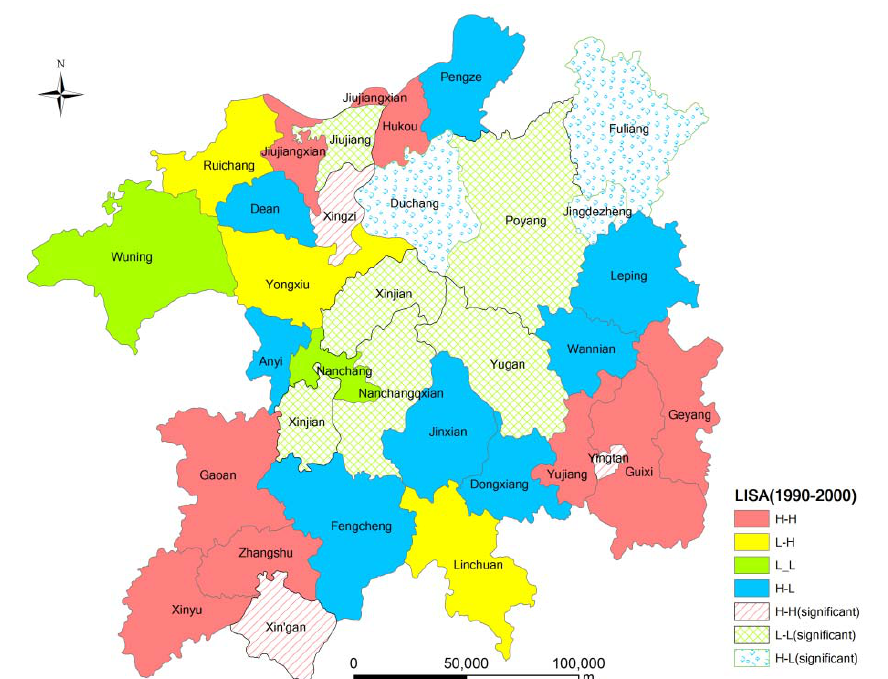
Figure 3. LISA clustering of ecological land change in the Poyang Lake Eco-economic Zone during 1990-2000 at the county